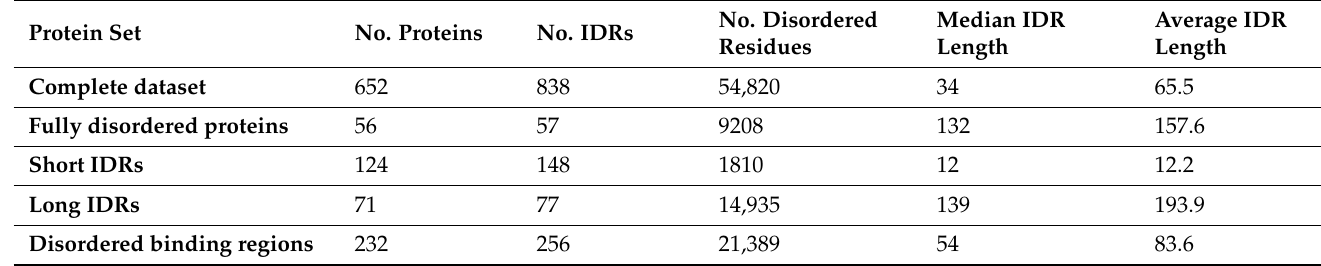
Table 1. Summary of IDPs and IDR data in the CAID